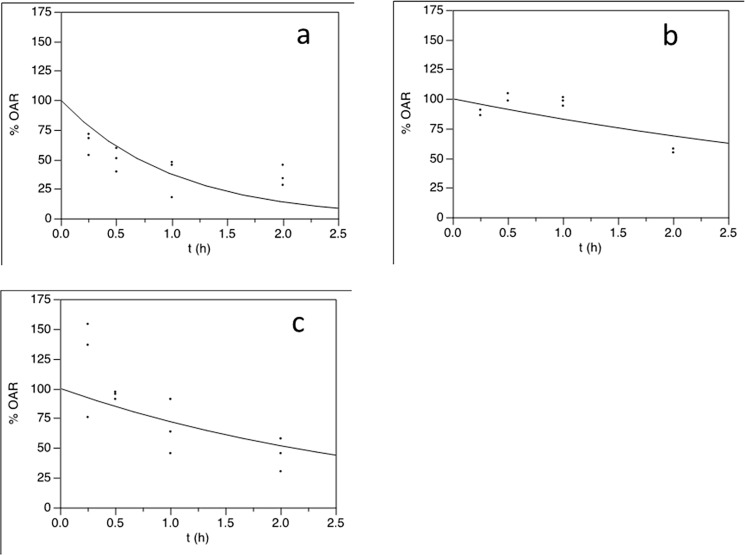
Inhibition of viral potency by sunlight treatment.Percentage of original activity remaining (%OAR) of LdMNPV-45/0 (dose 5x105 OBs/larvae, a), LdMNPV-27/0 (dose 5x106 OBs/larvae, b) and LdMNPV-27/0 (dose 5x105 OBs/larvae, c) strains exposed to sunlight UV.